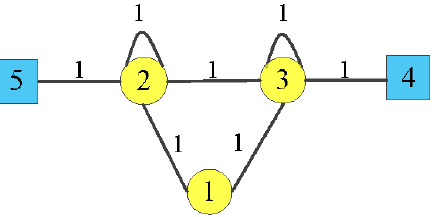
Figure 6. IEEE 5-bus system with 2 boundary nodes (square icon) and 3 interior nodes (circle